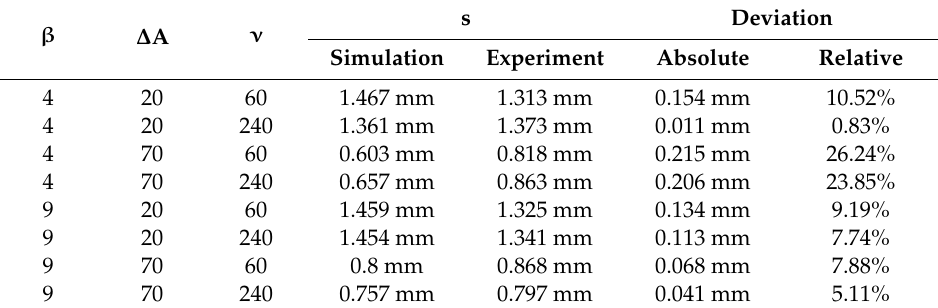
Table 5. Comparison of the average coating thicknesses after CWR between the simulations and the experimental trials as well as the deviation between simulation and experimental trial. s Deviation β ∆ A ν Simulation Experiment Absolute